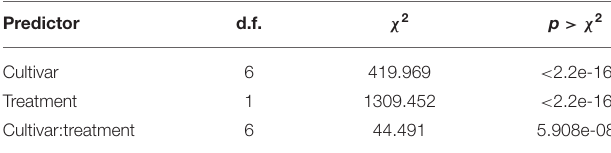
± 0.056 SEM), and “York” (0.356 ± 0.055 SEM) showed no